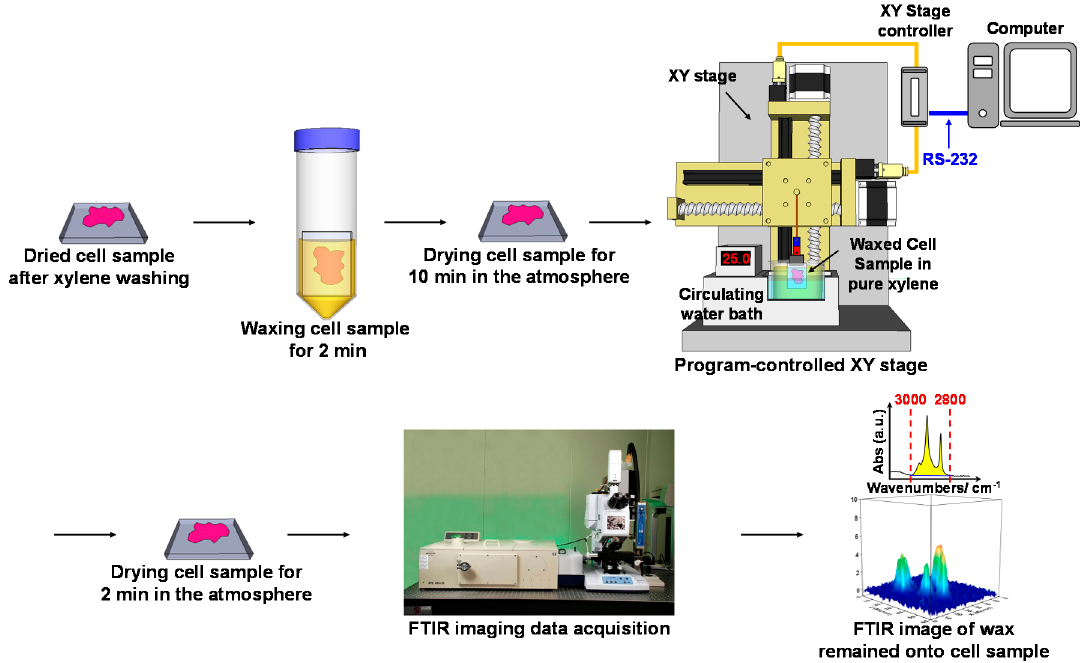
Figure 5. The schematic WPK-FPA-FTIR imaging procedure was demonstrated for estimating the amount of wax adsorbent remaining on the cell sample surface using IR absorbance of wax adsorbent in the range of 3000–2800 cm − 1 .